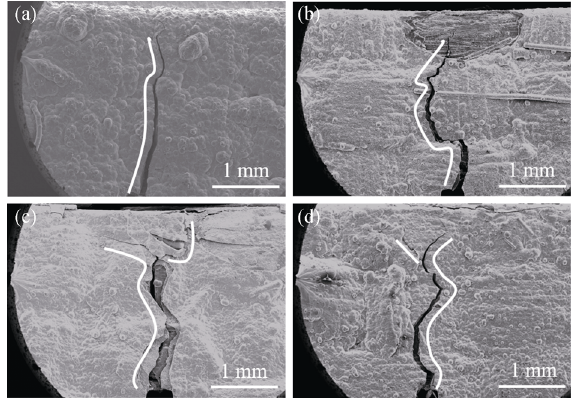
Fig. 7 Crack propagation path via fracture toughness test: (a) SiC f /SiC, (b) 1#, (c) 2#, and (d) 3#.